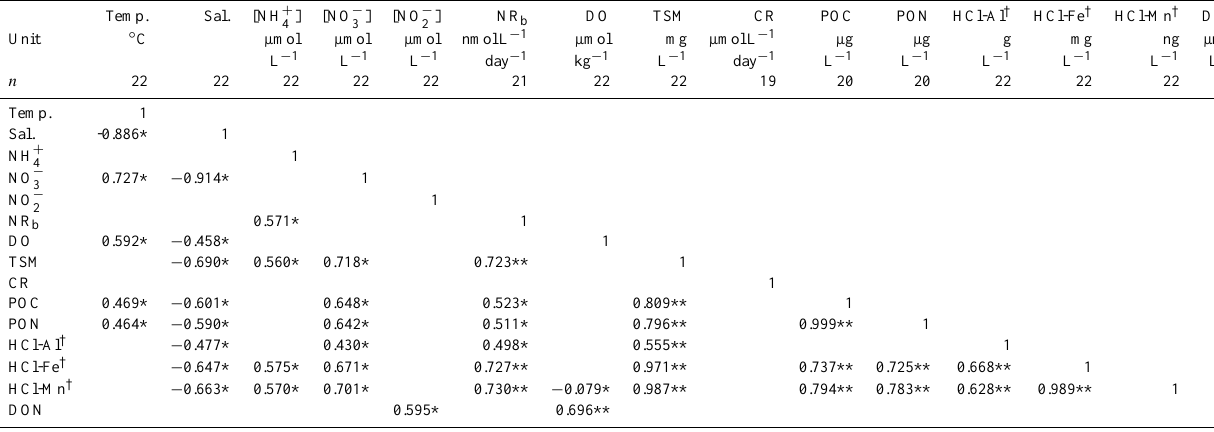
n is sample number. The other numbers are the Pearson’s correlation coefficient of two by two parameters. * indicates p < 0 . 05 and ** indicates p < 0 . 01 . † HCl-Al, HCl-Fe and HCl-Mn respectively indicate reactive Al, reactive Fe and reactive Mn which were extracted from suspended particles by 1NHCl. The method is described in Sect.